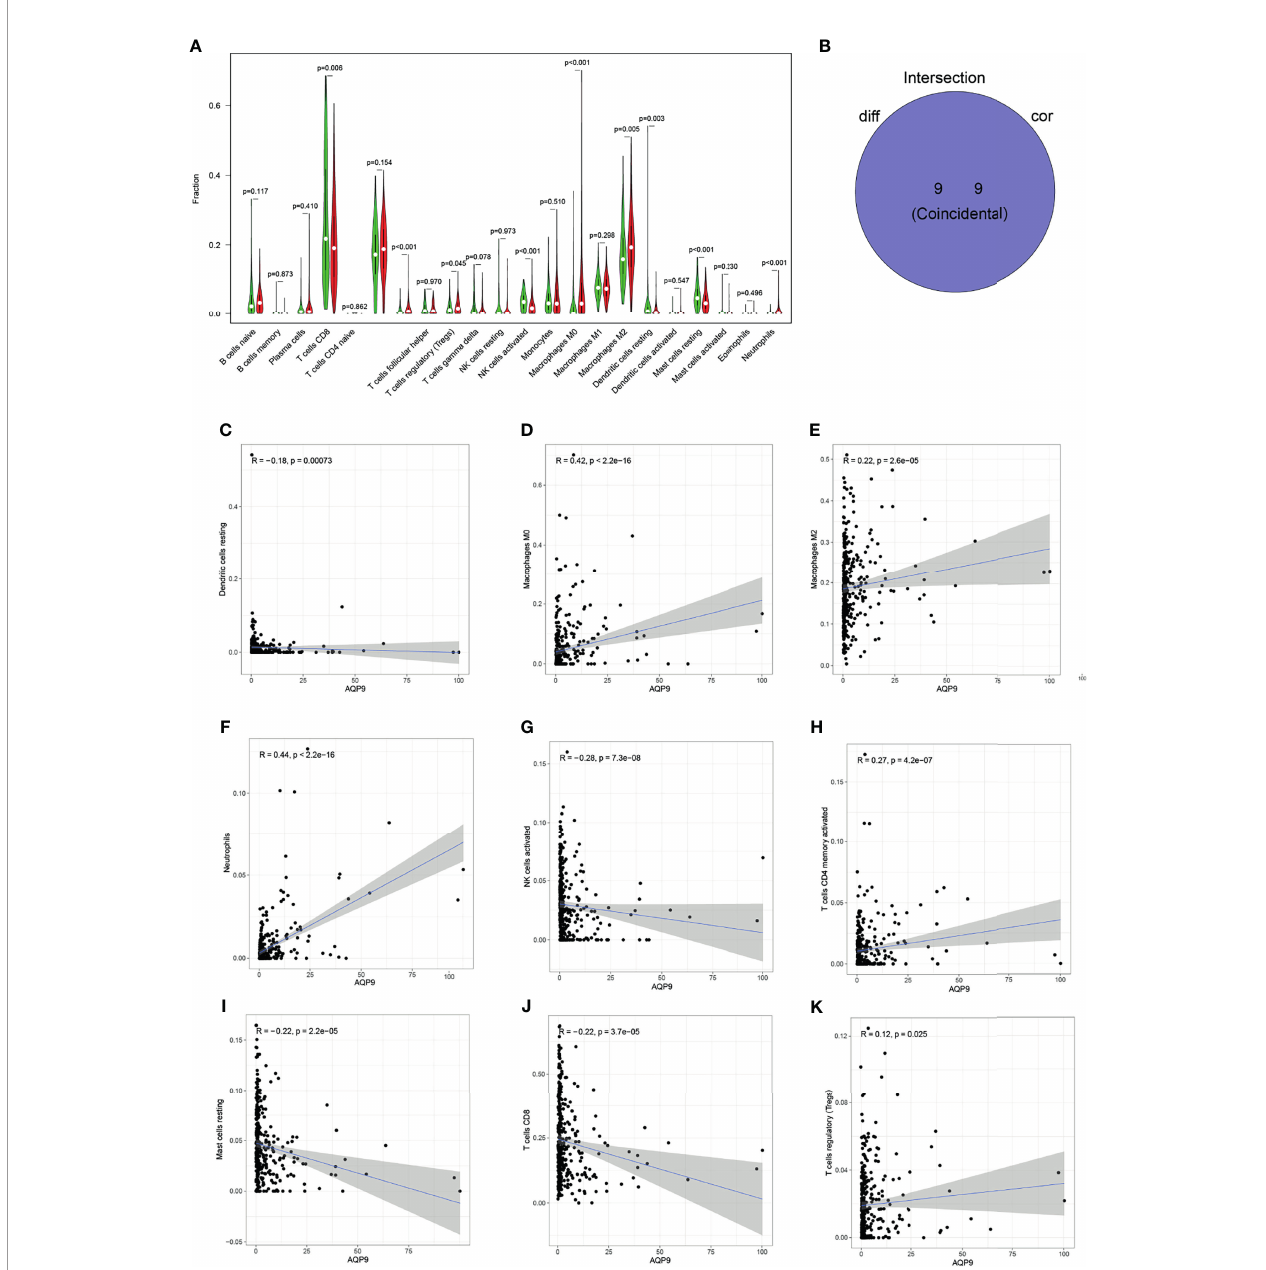
FIGURE 6 | Relationship between aquaporin 9 (AQP9) and immune cells. (A) The differential expression of various types of immune cells in cancer and adjacent tissues. (B) Overlap of correlation and differential analysis of AQP9. (C – K) Correlation analysis of the expression of AQP9 and the level of different immune